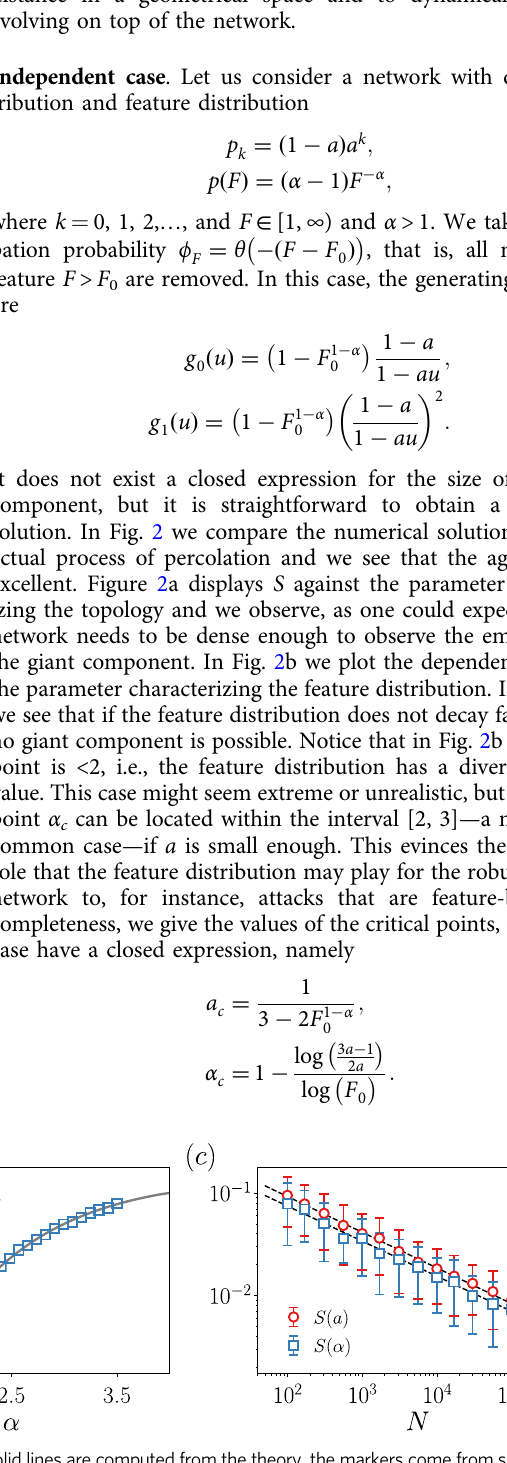
Fig. 2 Size of the giant component for the independent degree-feature case. Solid lines are computed from the theory, the markers come from simulations. In ( a ), the control parameter a is related to the topology, while in ( b ) the control parameter α is related to the feature distribution, see Eq. (6). Vertical lines indicate the value of the critical point computed from the theory, see Eq. (8). System size is N = 3000 and each point is computed by averaging over 100 independent realizations. In ( c ), the size of the giant component with error bars as a function of the system size, together with the fi ts to the